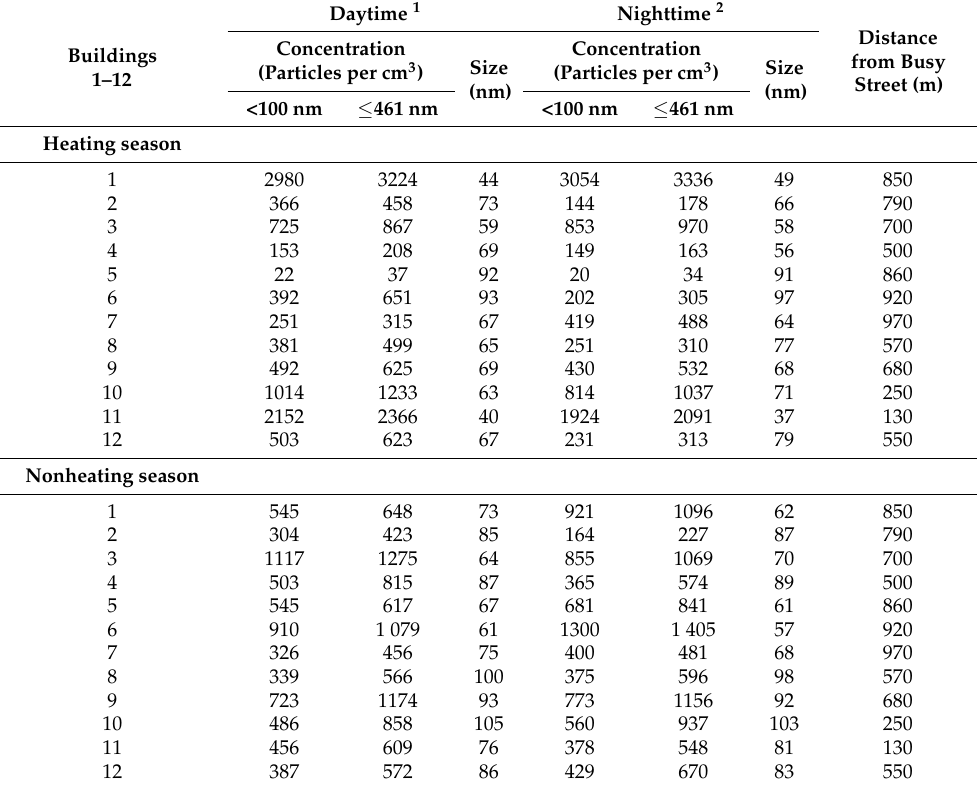
Table 2. Average concentrations of measured NPs ( ≤ 461 nm), ultrafine particles (<100 nm), and average sizes of NPs in twelve office buildings in Umeå during the heating and nonheating seasons, and the buildings’ distances from a busy street. The buildings and their numbers are presented in Figure 1.